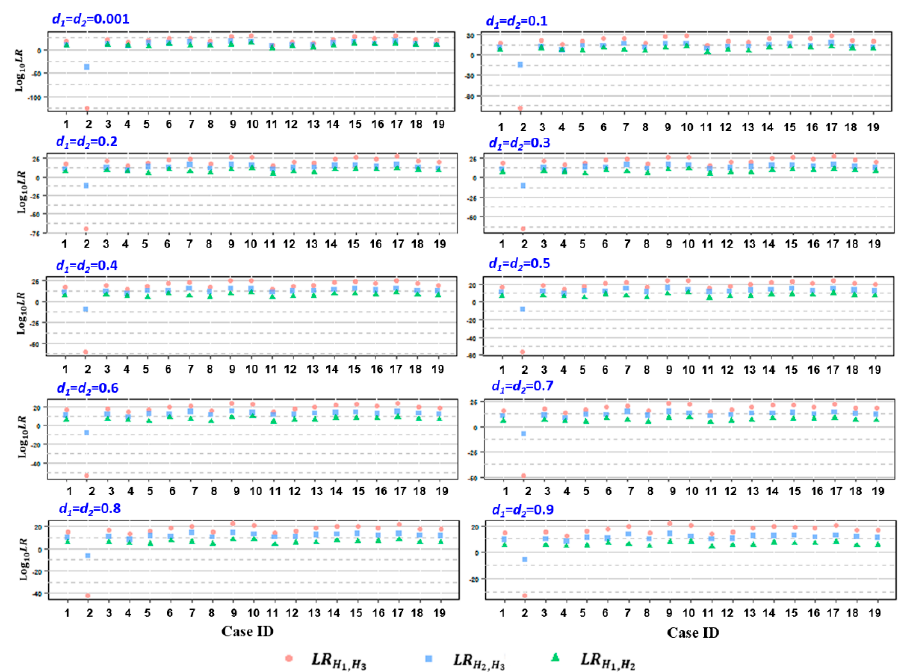
Figure 2. The distribution of log 10 LRs, including LR H1 , H3 (pink circle), LR H2 , H3 (blue square), and LR H1 , H2 (green triangle), attained from the 19 studied cases, assuming equal dropout probability d for both twins. d 1 and d 2 represent the individual d values of the twin fetus, ranging from 0.001 ~ 0.9.